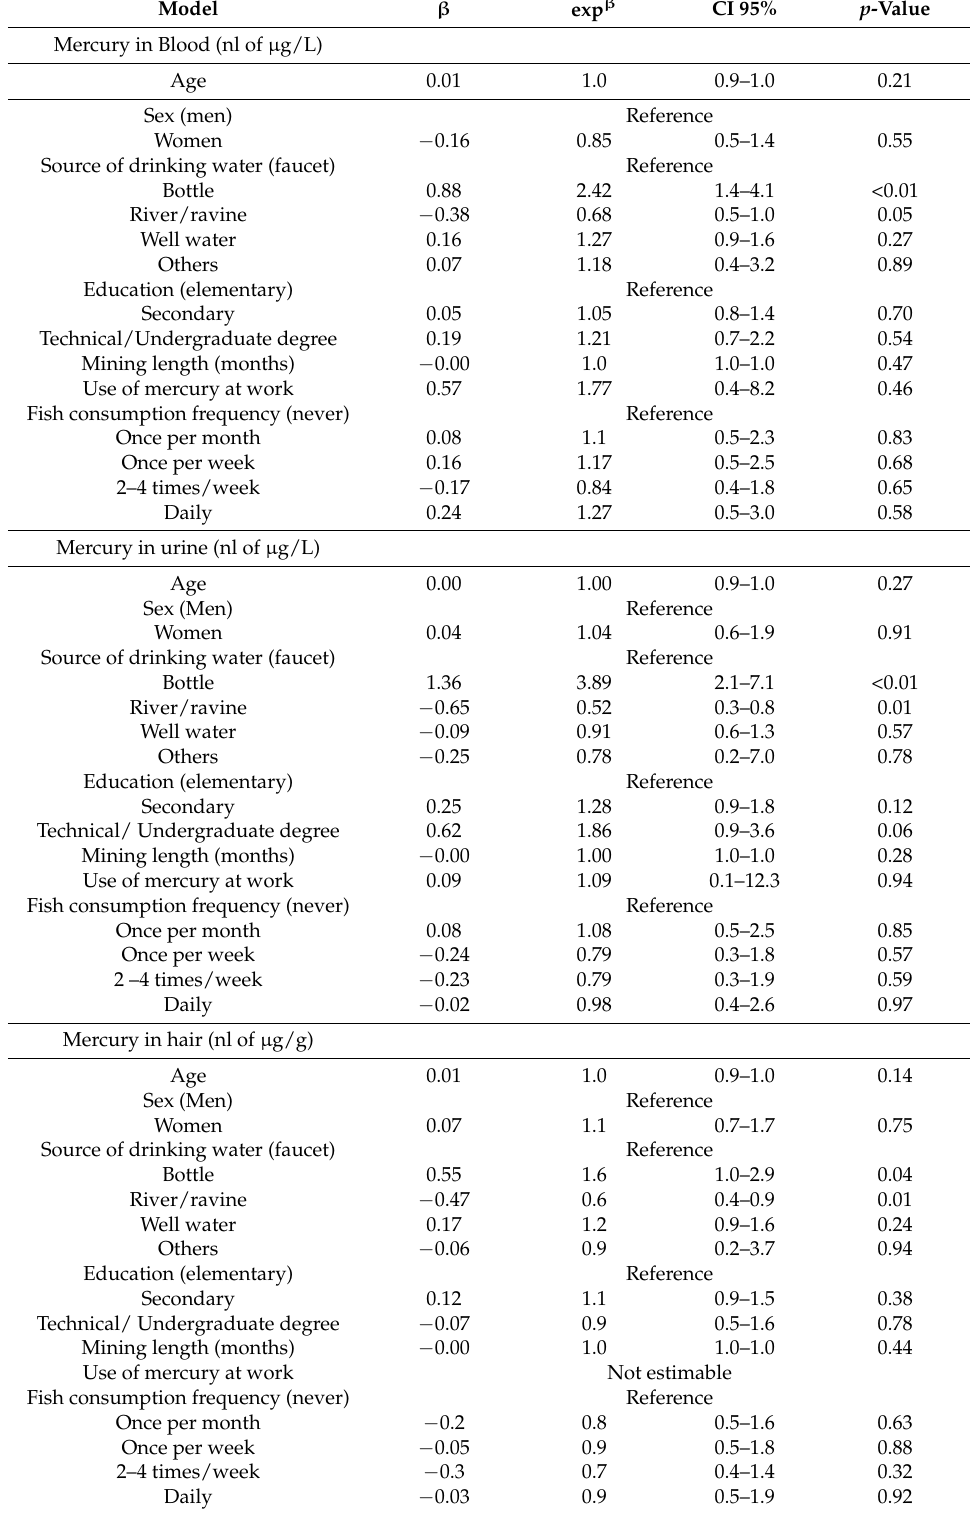
Table 4. The multiple linear regression models for mercury levels in different biological matrices in the La Mojana region,